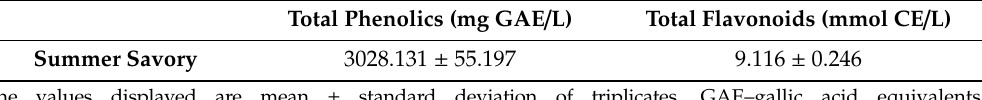
Table 2. Total phenolic and flavonoid content of Summer Savory